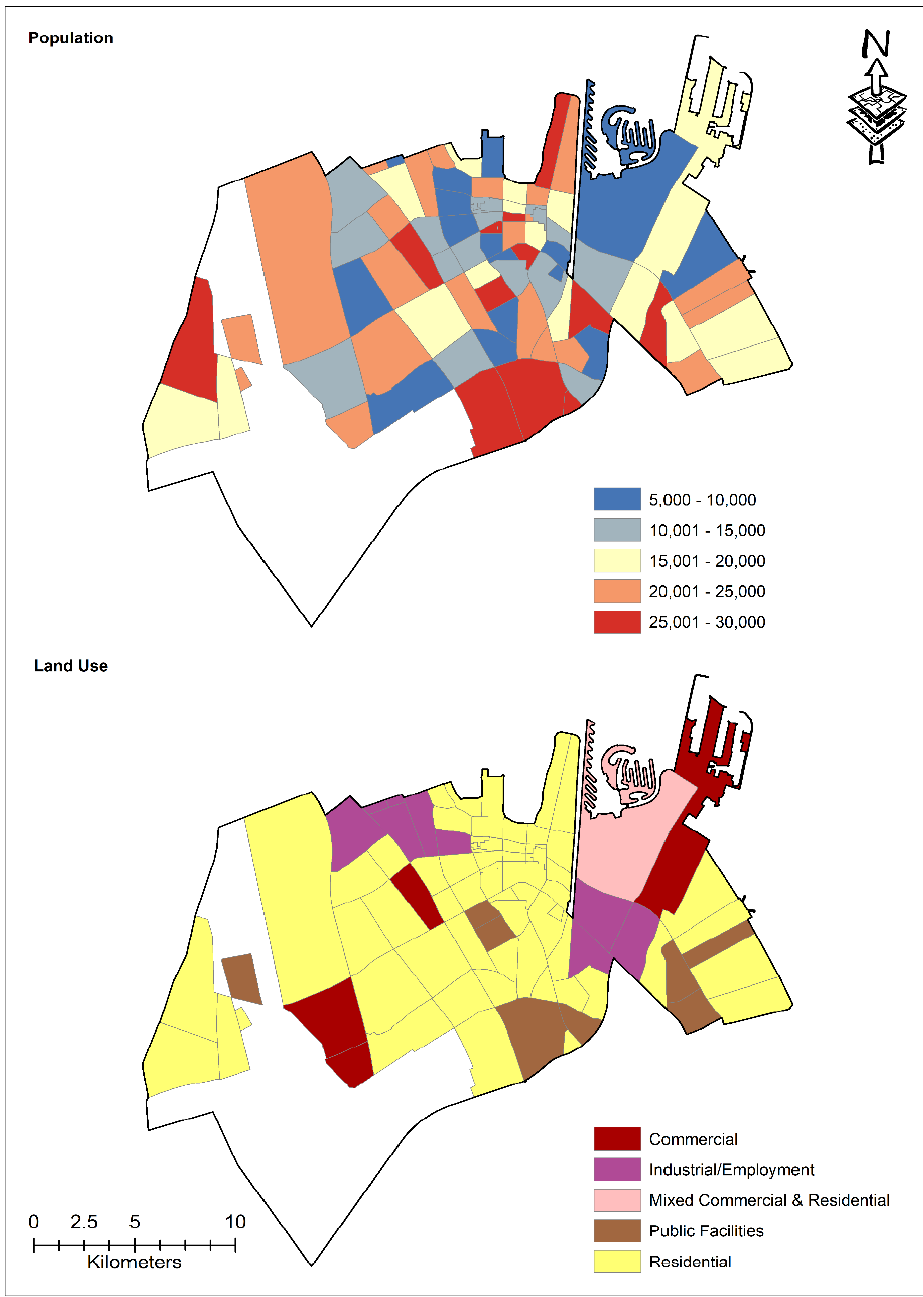
Figure 2. Population and land use map of the study area.